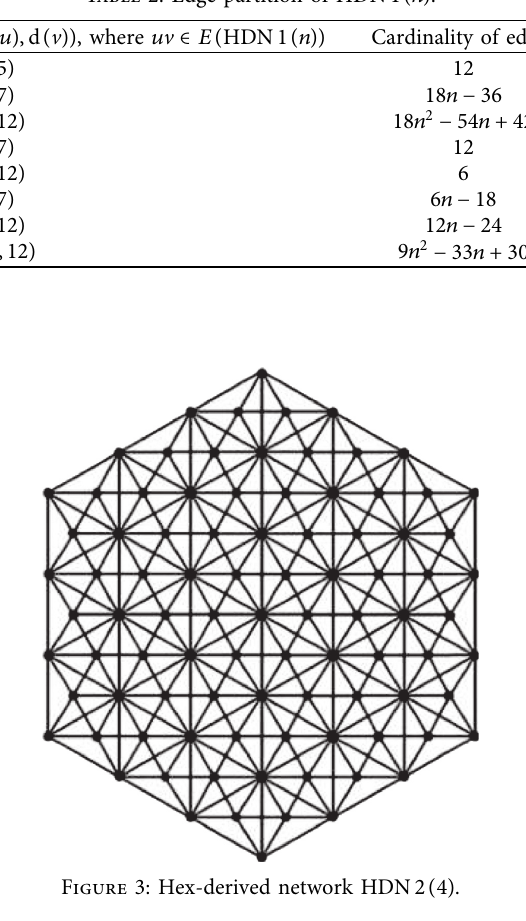
Table 2: Edge partition of HDN 1 ( n ) .